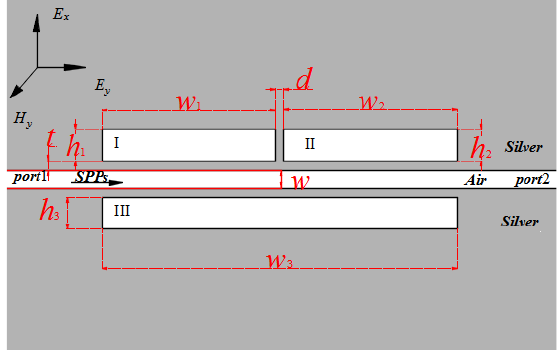
Figure 1. Structure diagram of a MIM structure with three rectangular resonators.